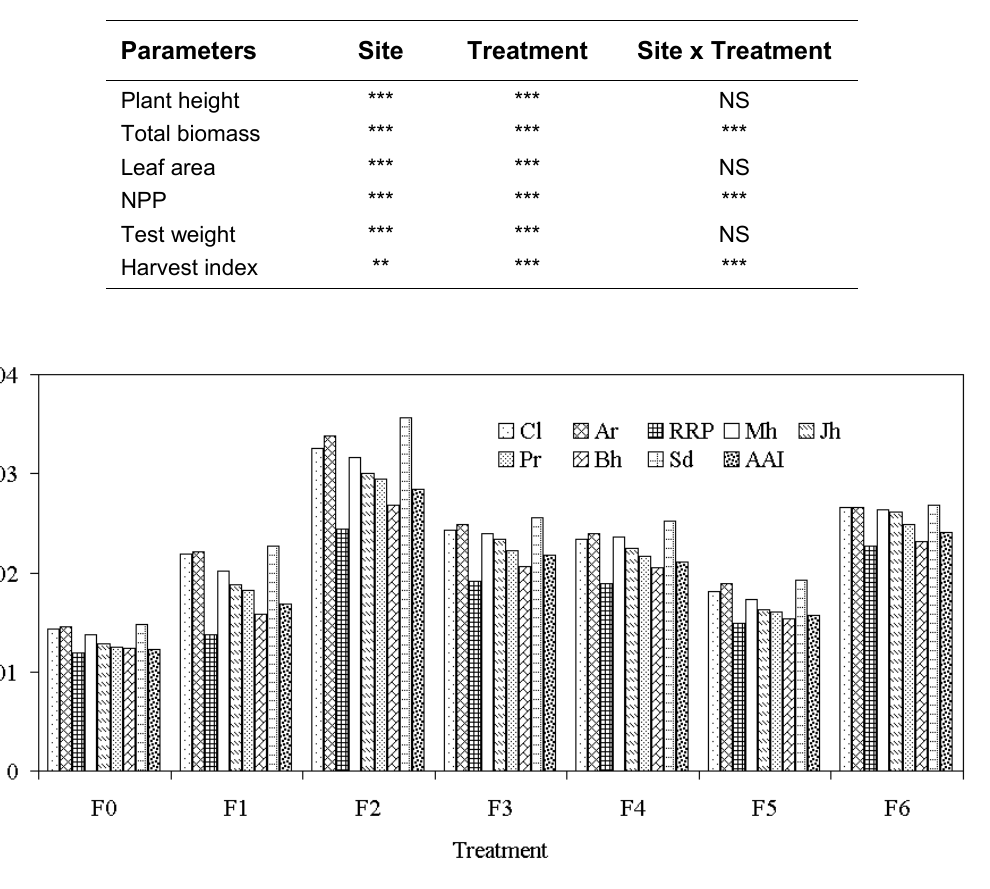
FIGURE 3. Effect of different fertility levels on net primary productivity of wheat plants grown at various